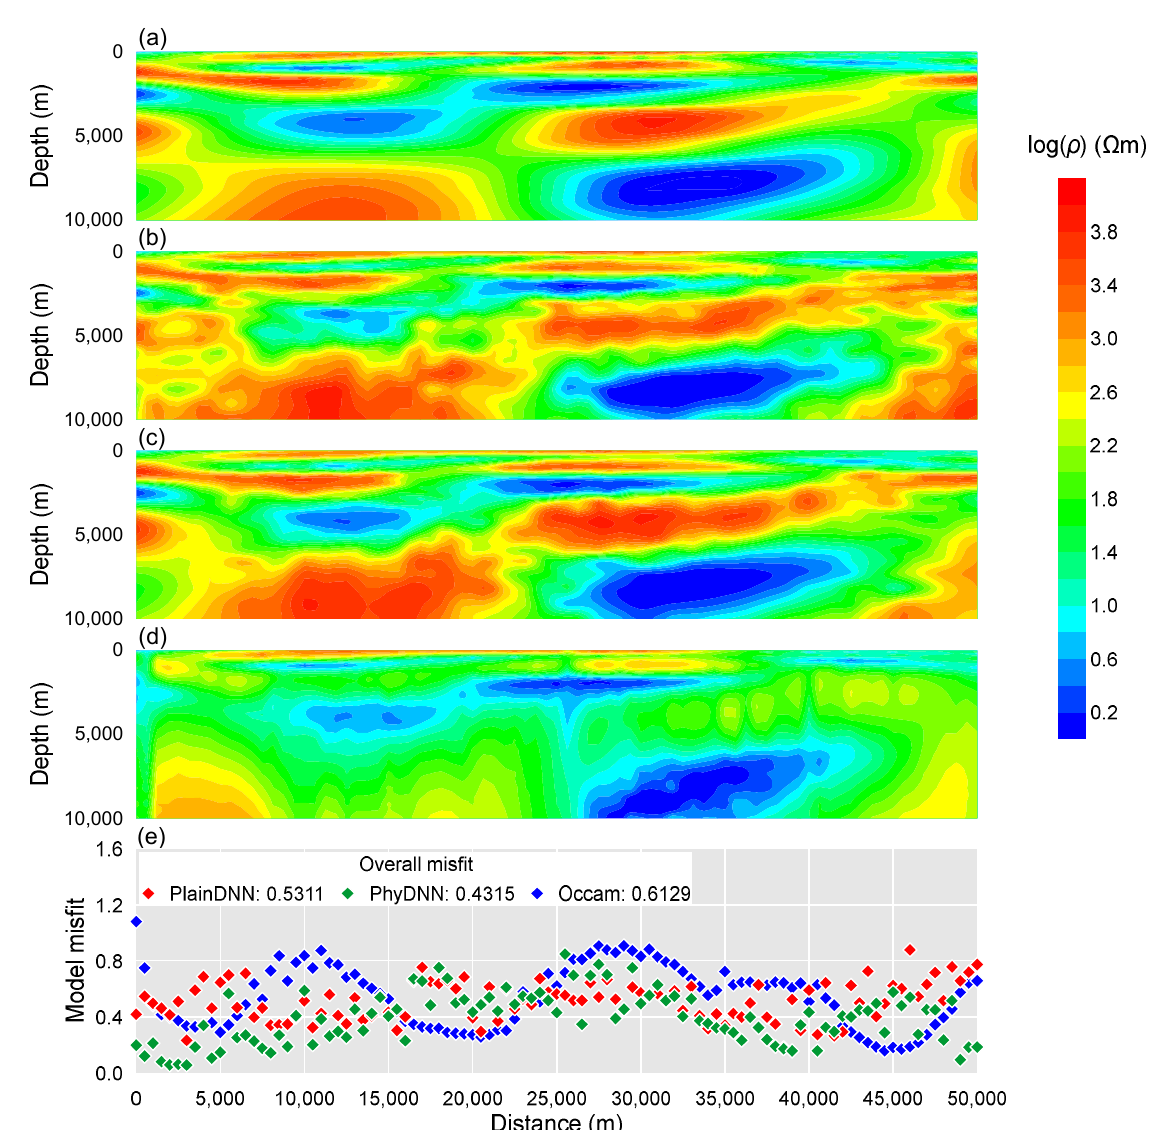
Figure 14. Comparison of the inversion results for subsurface resistivity model ( a – d ) are the retrieved models of the PlainDNN, PhyDNN and Occam, respectively. ( e ) shows the individual model misfit for all sites and the overall model misfit of the whole model. The MT responses used for inversion are mixed with Gaussian noise at 1% level.